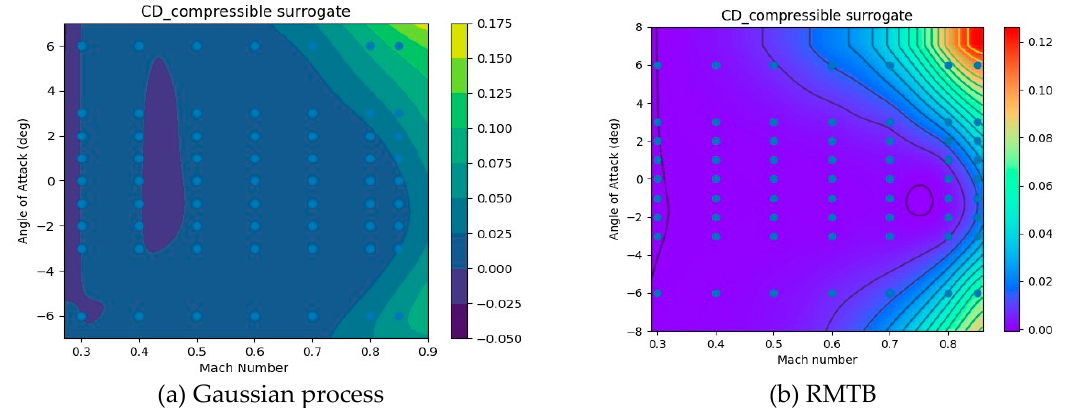
Figure 6. Comparison between the RMTB and Gaussian process surrogates for the compressibility drag coefficient.